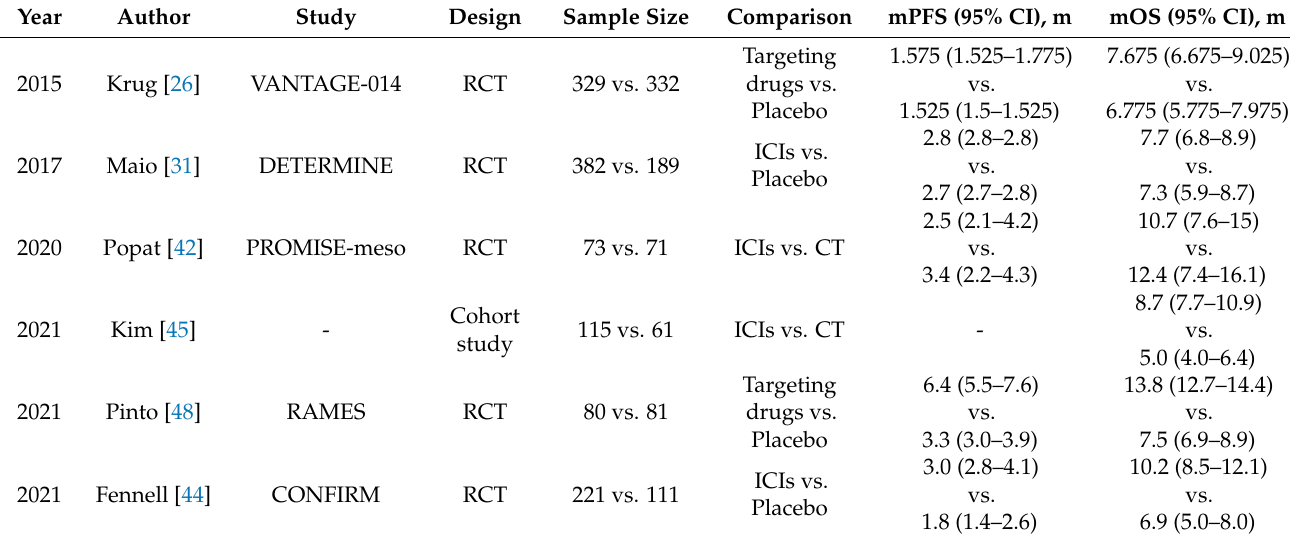
Table 3. Measure outcomes of RCTs and cohort study.